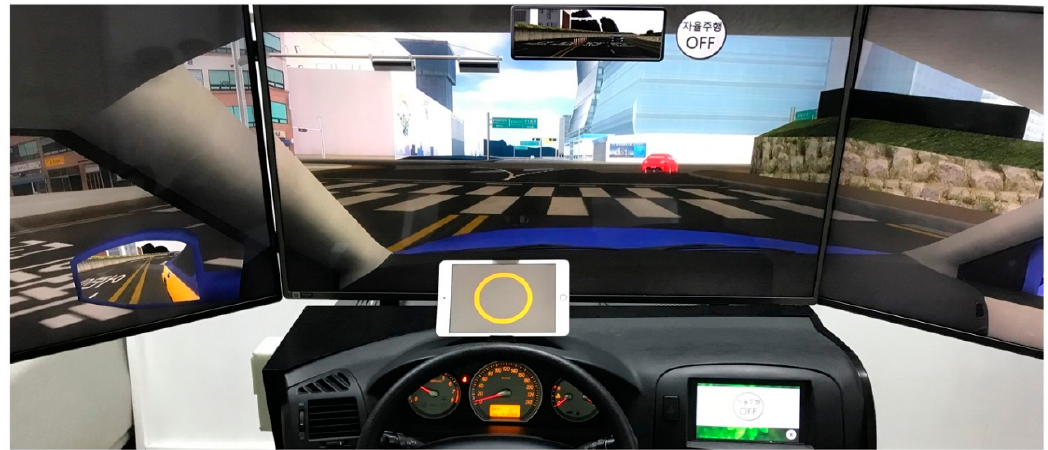
Figure 2. Experimental Environment with Simulator and Intelligent Driving Assistant.